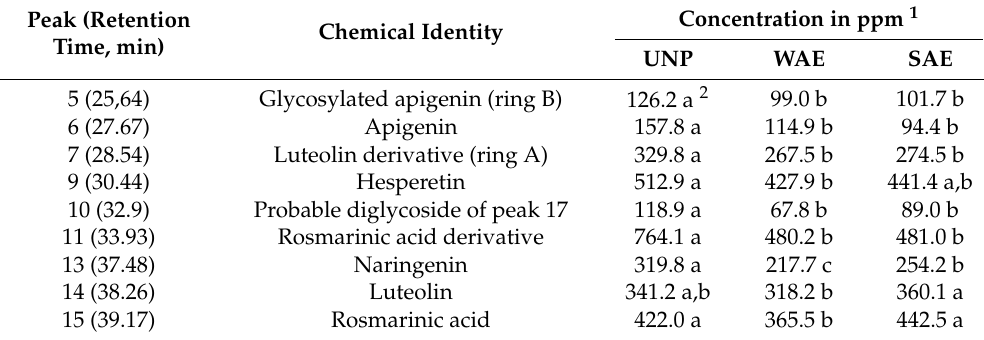
Table 6. Comparative analysis of phenolic composition in thyme extracts by HPLC-PDA. Peak